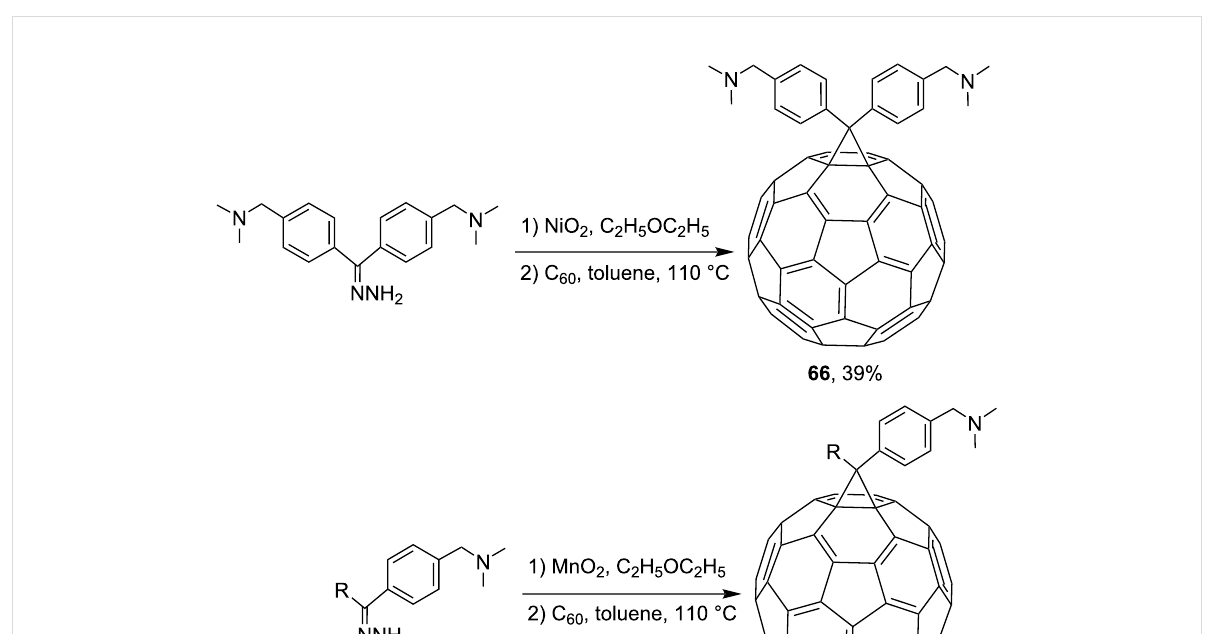
Scheme 20: Synthesis of N - containing fullerene ligands 66 – 68 .